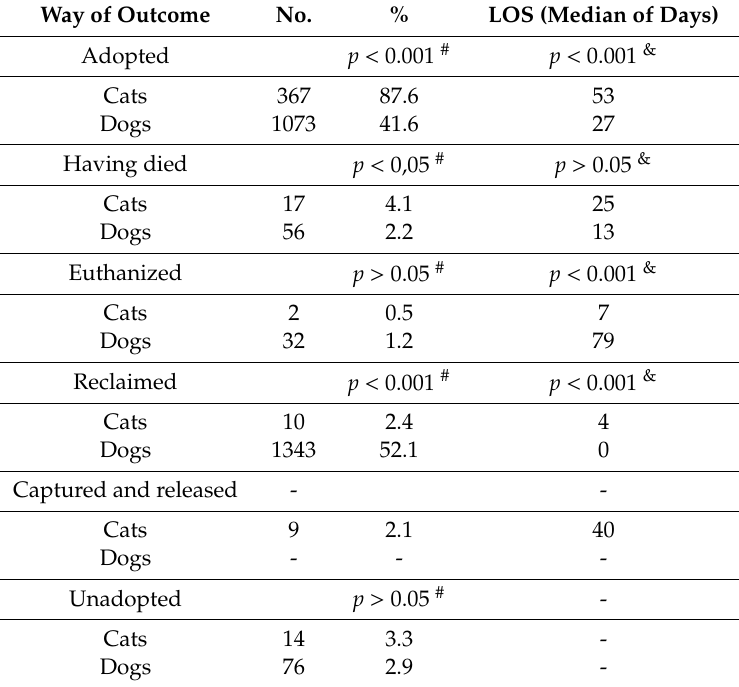
Table 1. Population of evaluated cats and dogs; number of animals and the median LOS in variables of the way of